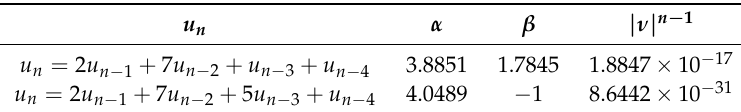
Table 1. Fourth order linear recurrences.